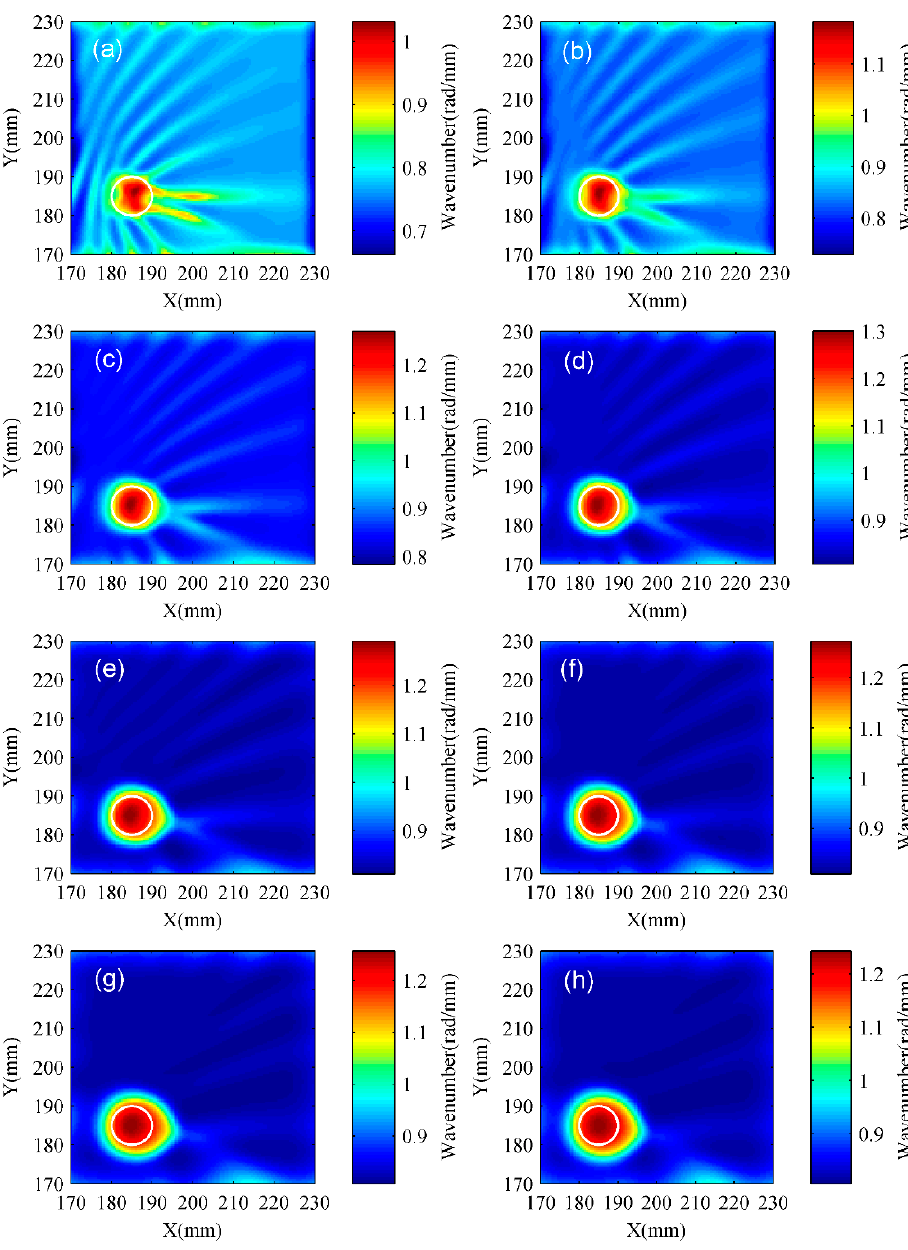
Figure 24. The test results obtained under various window radii. ( a ) 5 mm; ( b ) 6 mm; ( c ) 7 mm; ( d ) 8 mm; ( e ) 9 mm; ( f ) 10 mm; ( g ) 11 mm; ( h ) 12 mm. The white circle represents the actual location of the damage. The central frequency of the excitation signal is 400 kHz. A circular flat bottom hole is located in (185, 185).